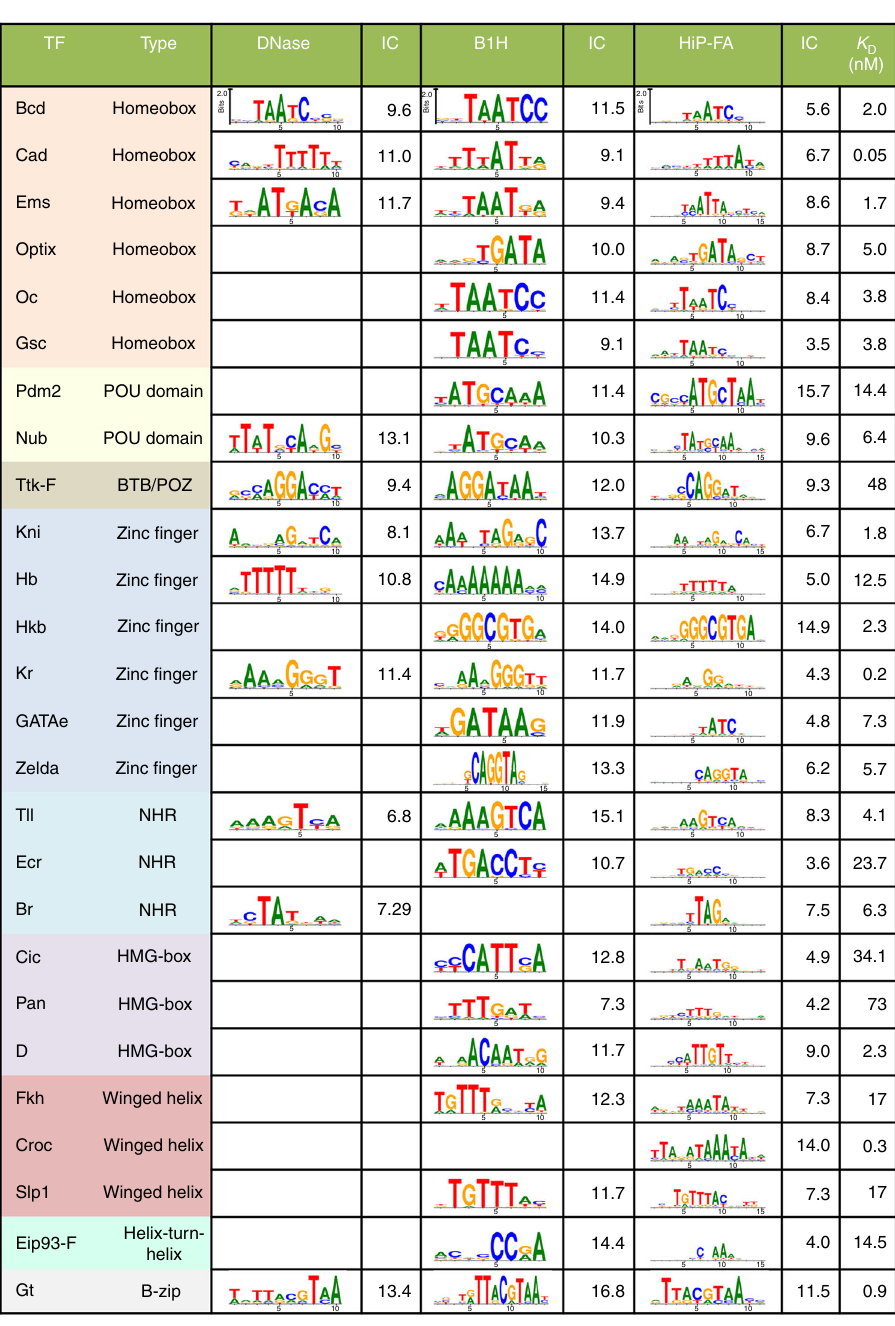
Fig. 3 Binding speci fi cities of 26 Drosophila transcription factors. The proteins are grouped by type of DNA-binding domains. HIP-FA PWMs are compared with PWMs derived from DNase footprinting 2, 24 and bacterial one-hybrid (B1H) selection. 8 Overall, the HIP-FA binding motifs agree with the previous data, but show lower binding speci fi city combined with high binding af fi nities. Information content (IC; in bits) and HIP-FA-measured K D s for the consensus sequences are